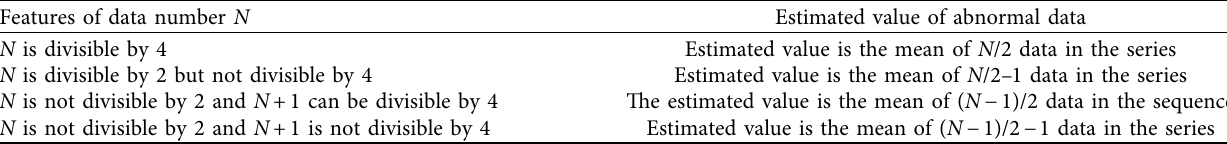
Table 2: The mean value of the intermediate